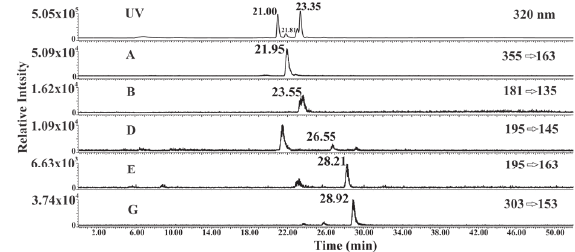
Figure 3 - Chromatogram of the lyophilized coconut water by LC/MS/MS spiked with standards. Injection of 75 mg/mL solution of LCW in ACN 10% with formic acid 0.1% plus mixed standard compounds solution. The lyophilized CW was analyzed by Kinetex C18 XB (100 mm x 4.6 mm i.d., 2.6 µm